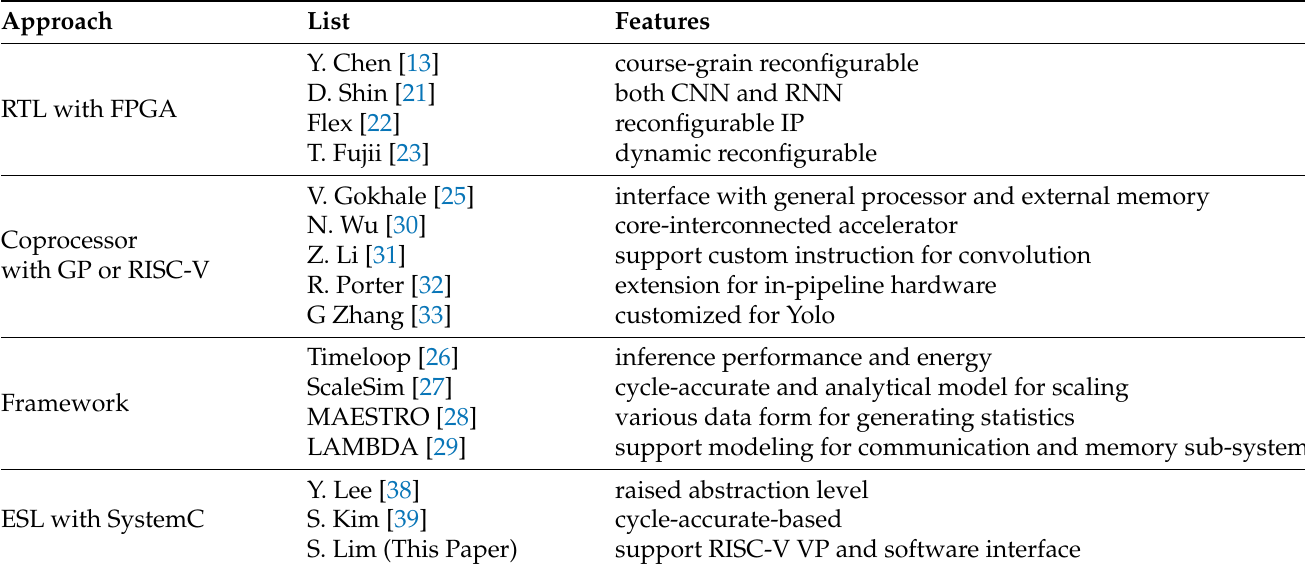
Table 1. List of various DNN accelerators and their approaches for architectural